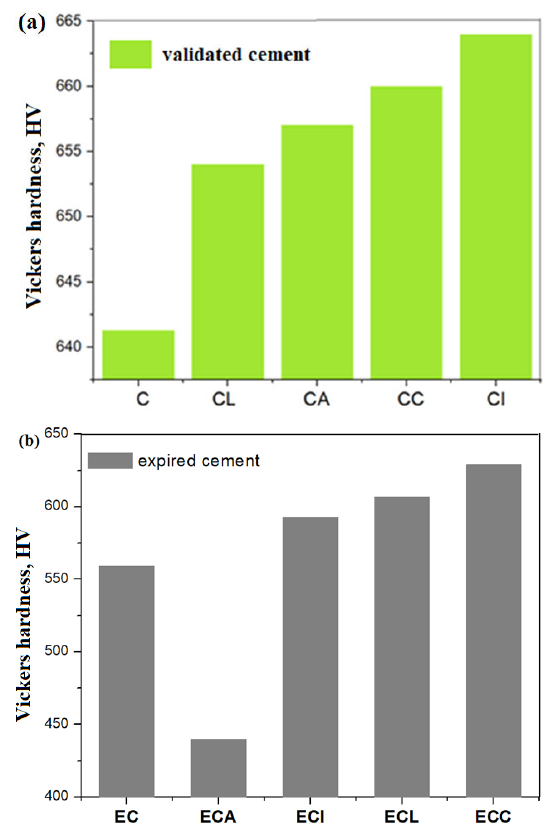
Figure 9. Influence of composites nature on the Vickers hardness values distribution of compo ‐ site ‐ cement materials for the mixture with ( a ) Portland cement and ( b ) expired cement, the measurements were applied after 28 days.